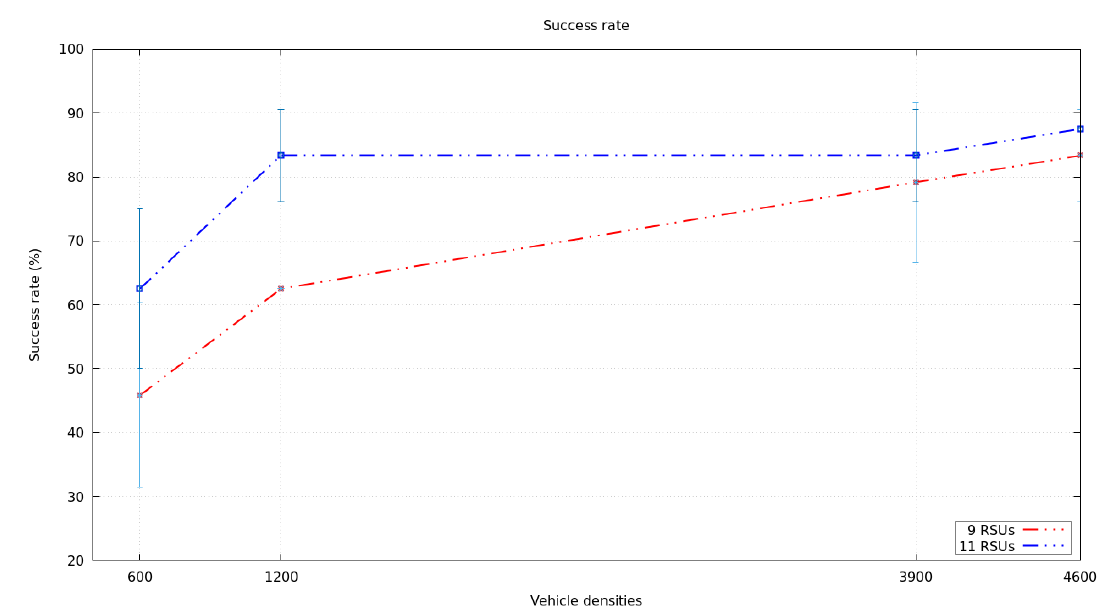
Figure 8. Message delivery success rate.